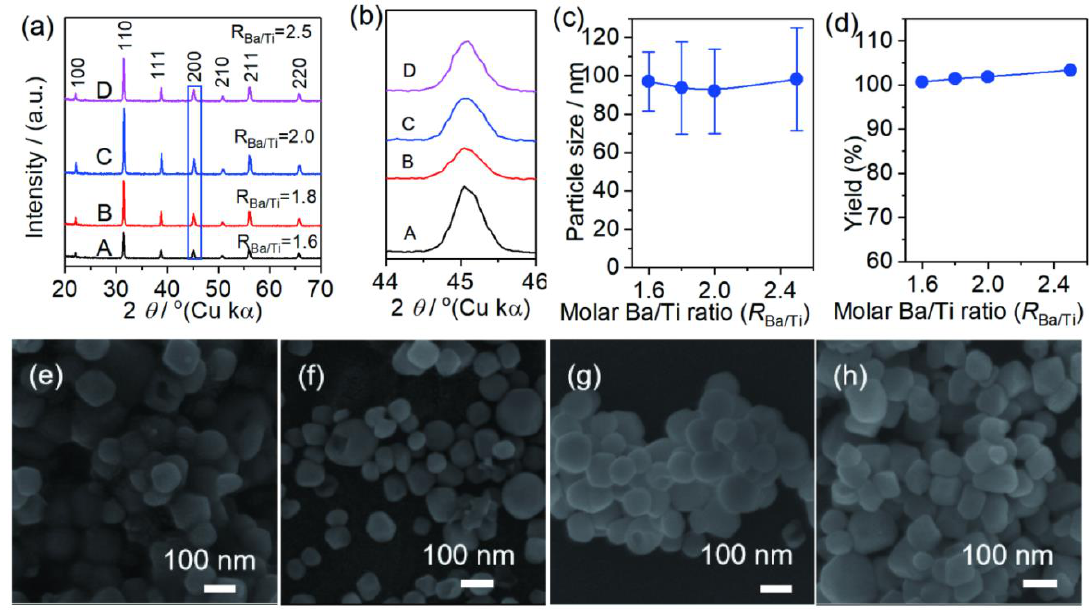
Figure 3. X-ray diffraction (XRD) patterns ( a , b ), particle sizes and yields ( c , d ), and scanning electron microscope (SEM) images ( e – h ) of the BaTiO 3 samples obtained with various molar Ba / Ti ratios ( R Ba / Ti = 1.6–2.5) under hydrothermal conditions at 200 °C for 8 h ([NaOH] = 2.0 mol L −1 , pH ≈ 13.6).